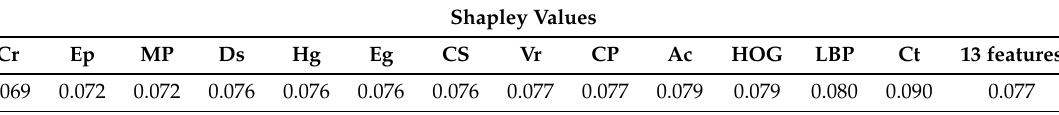
Table 2. A sample of Shapley values of DECEDM texture